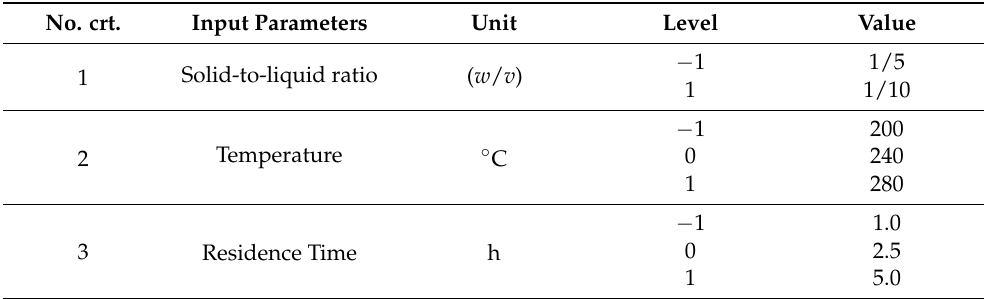
Table 2. The input parameters